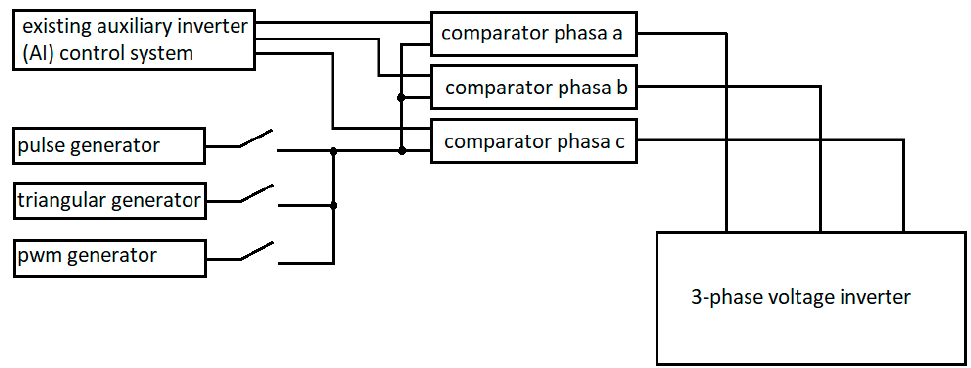
Figure 11. Concept of the modified auxiliary inverter (AI) control system for the variant when a pulse generator, triangular generator, and PWM are used.